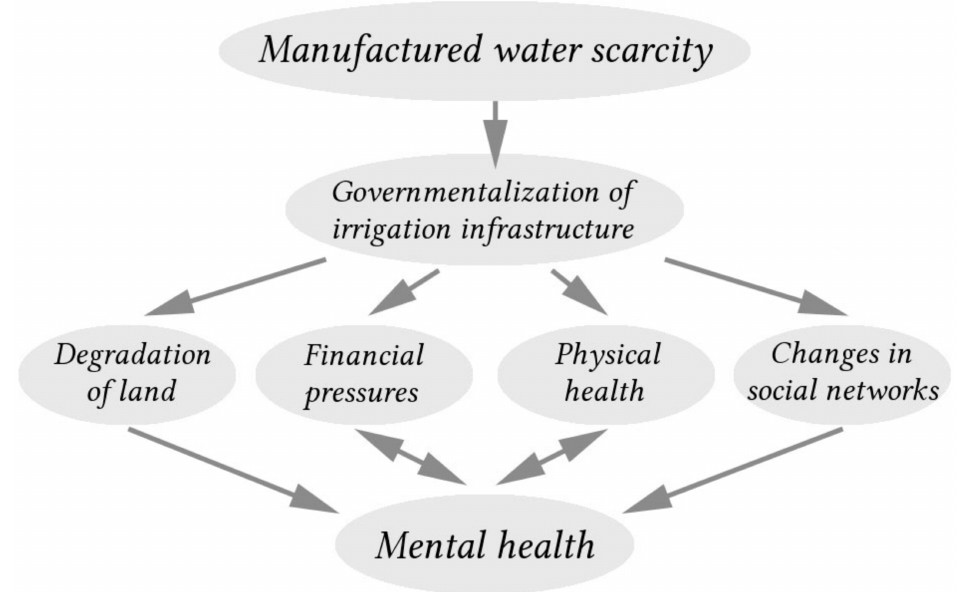
Figure 2. Manufactured water scarcity and the pathways to mental health